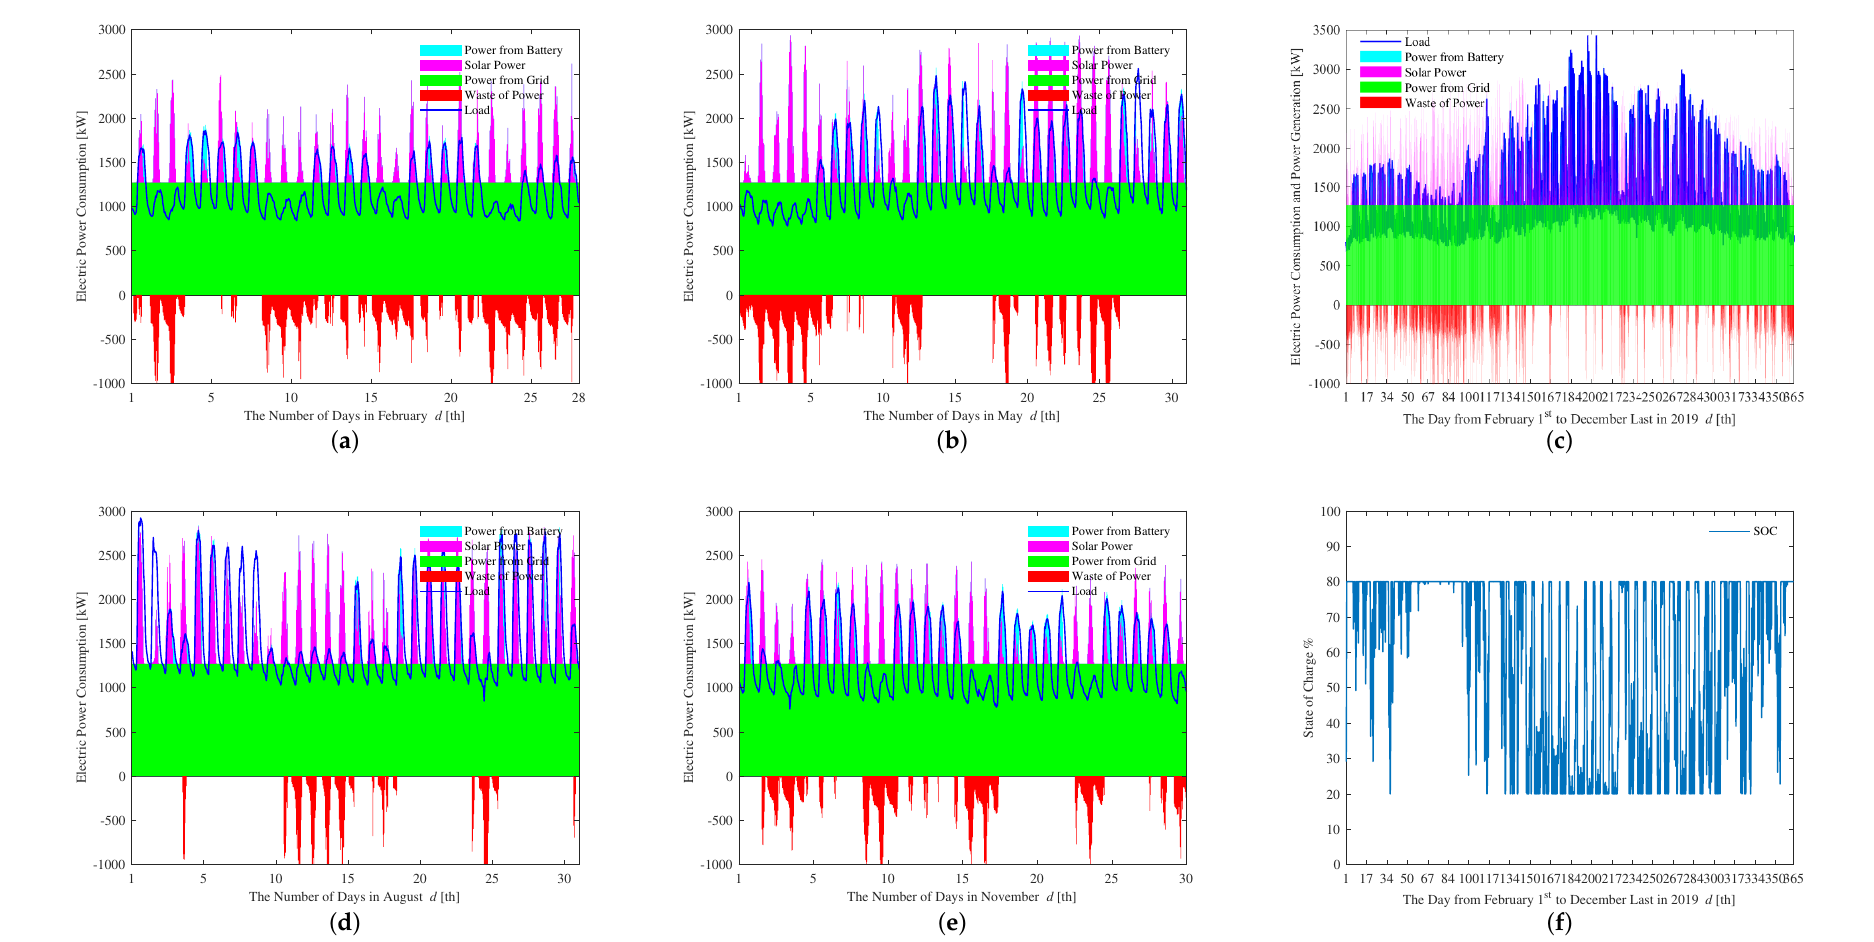
Figure 10. Simulation result of Case 2. ( a ) Simulation result of February; ( b ) Simulation result of May; ( c ) Simulation result of the whole year; ( d ) Simulation result of Augus; ( e ) Simulation result of November; ( f ) Simulation result of the whole year’s